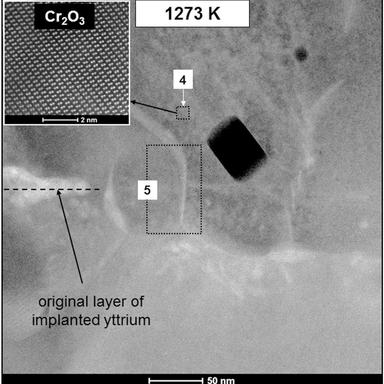
STEM-HAADF image of the area marked "2" in A; rectangle marked "5" indicates the area where the grain boundary in the scale is located; Inset: area marked "4" shown at an atomic resolution.